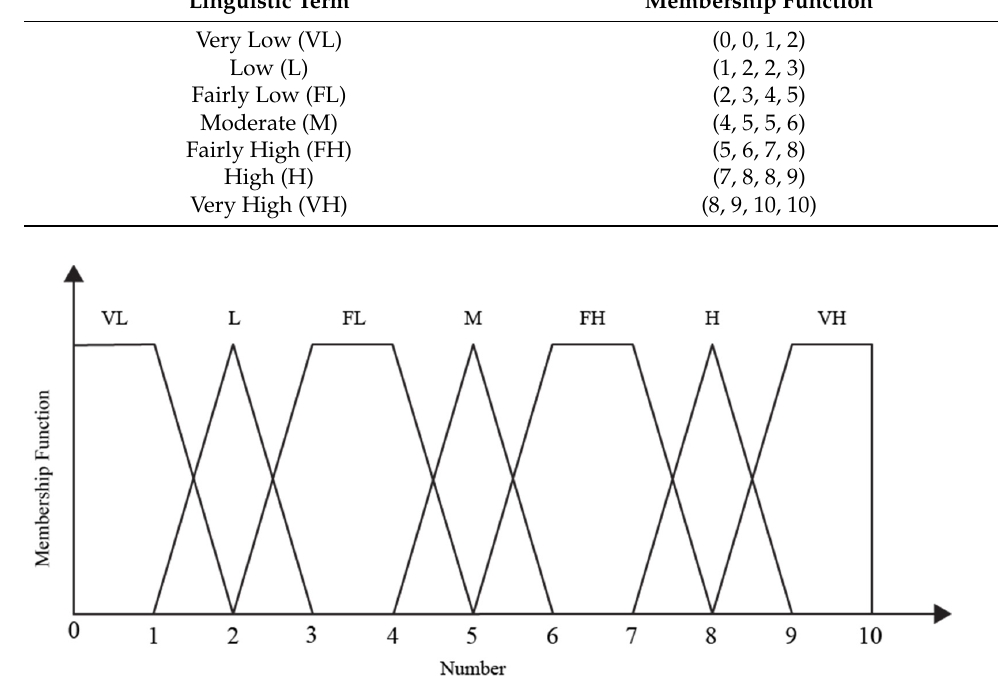
Figure 4. Membership functions of the linguistic